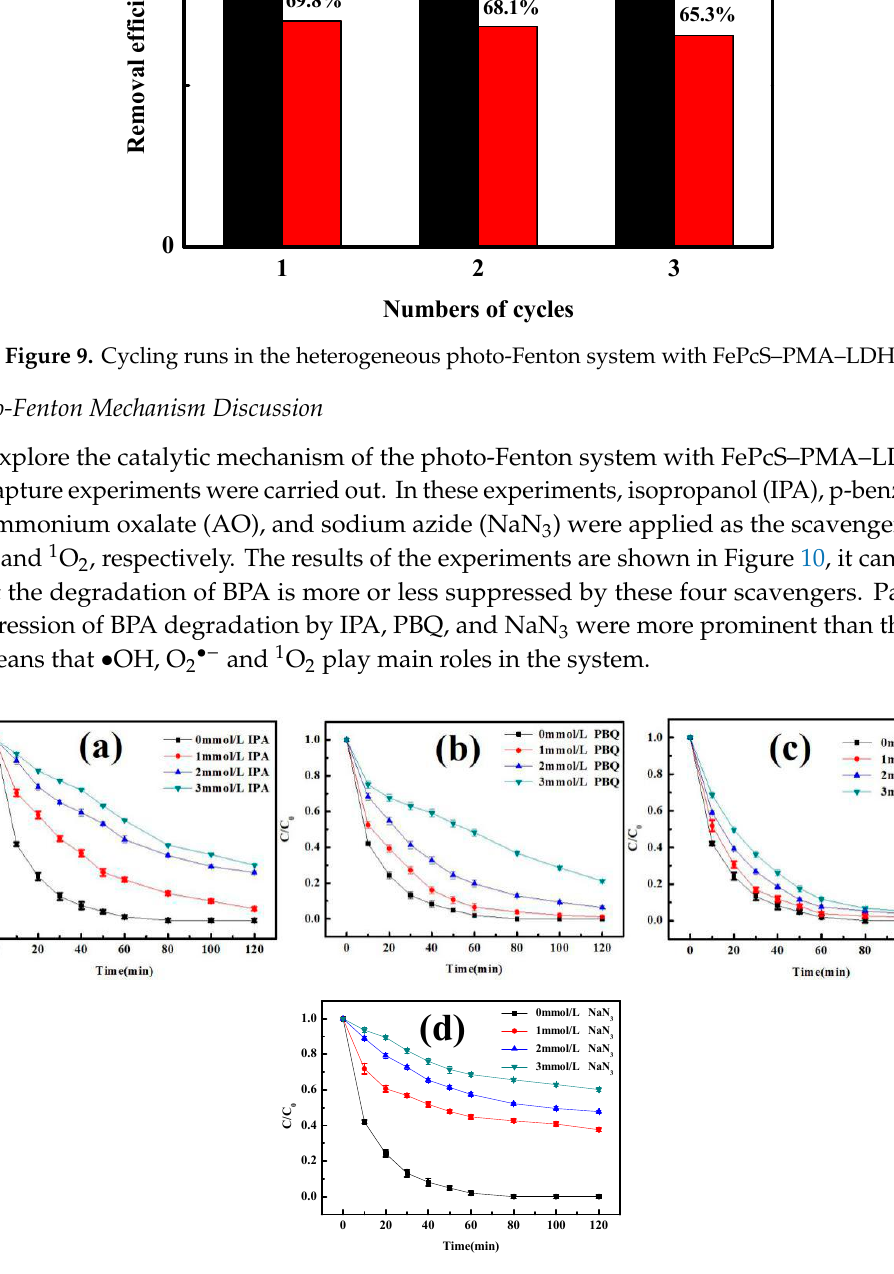
Figure 10. Effects of ( a ) isopropanol, ( b ) p-benzoquinone, ( c ) ammonium oxalate (AO), and ( d ) sodium azide (NaN 3 ) on the degradation of BPA in the heterogeneous photo-Fenton system with FePcS–PMA–LDH.